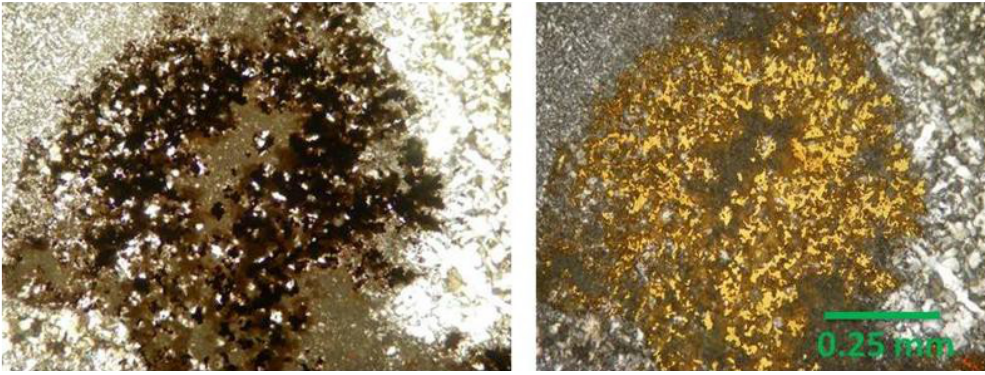
Figure 3. Photomicrographs of a single fractal dendrite from an electrum-rich band, similar to those shown in Figure 2 (from a polished thin section). This is a 30 µm-thick slice through a feature that is ~1 mm in diameter. Left : transmitted light, polars not crossed. Opaque phase is electrum, dark gray is barely (re)crystallized opal, and white is fine-grained quartz; Right : Same view as in left image, transmitted and reflected light, polars partially crossed. Note: dendrite is composed of nothing but opal and electrum (yellow) and opal is virtually opaque with polars crossed.